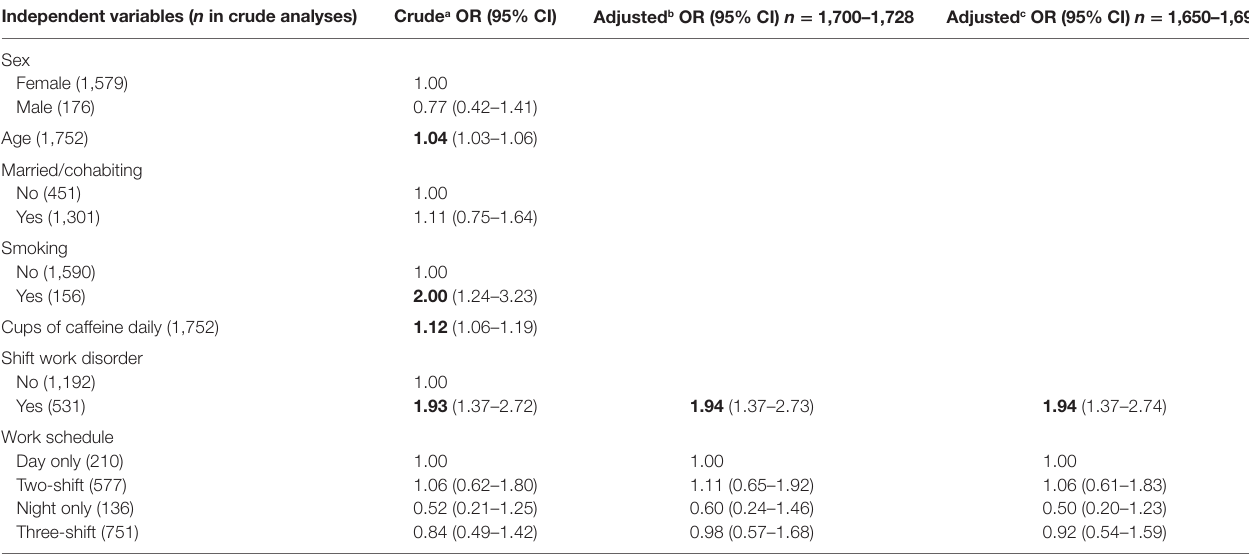
TaBle 4 | Logistic regression analyses with severe and frequent RLS/WED as the dependent variable among shift working nurses in Norway ( n = 1,788). independent variables ( n in crude analyses)